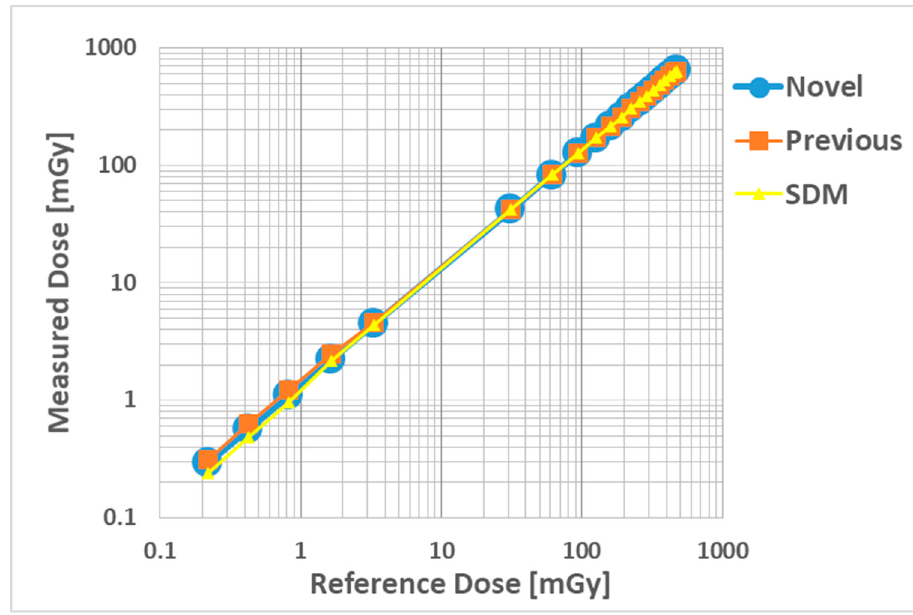
Figure 6. Dose dependence compared with the novel, previous sensors and SDM. Linear regression functions; novel dosimeter (R 2 = 1.0000, y = 1.3501x - 0.2001), previous dosimeter (R 2 = 1.0000, y = 1.3436x + 0.3608), SDM (R 2 = 1.0000, y = 1.3471x + 0.0362). R 2 : determination coefficients.